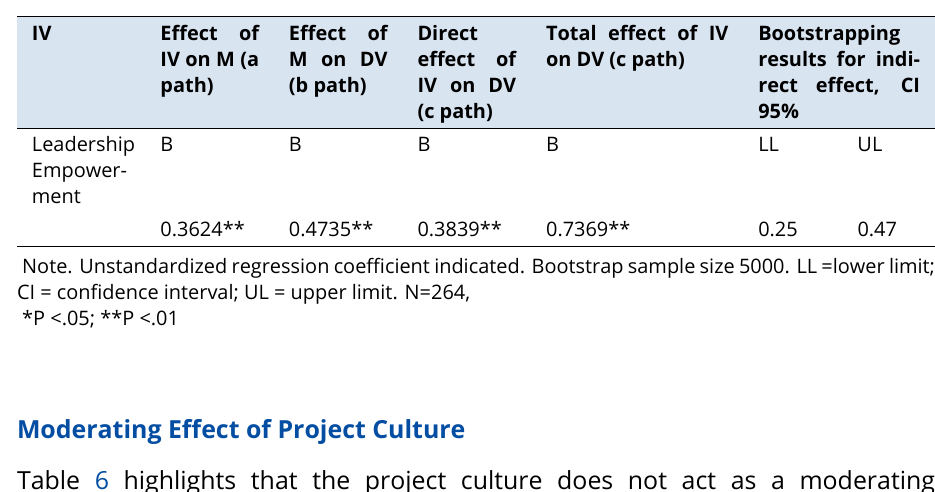
Mediation Analysis of Creative self-efficacy on IV (LE) and DV